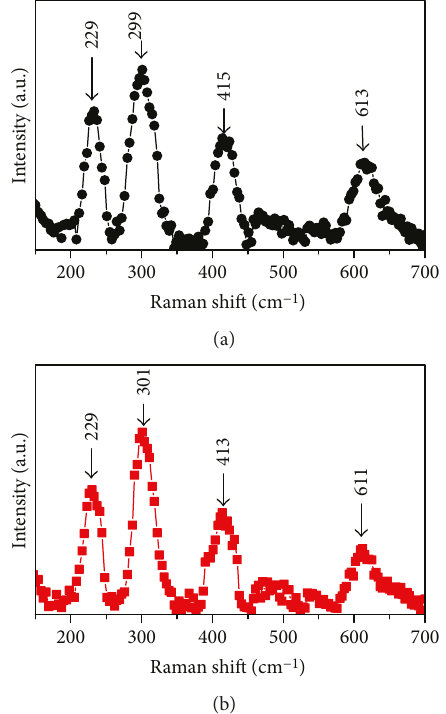
Figure 9: Raman spectra, in the 150 – 700cm − 1 range, of SC3 ((a): black circles) and SC4 ((b): red squares) pottery fragments. The peaks corresponding to the main features of haematite are also